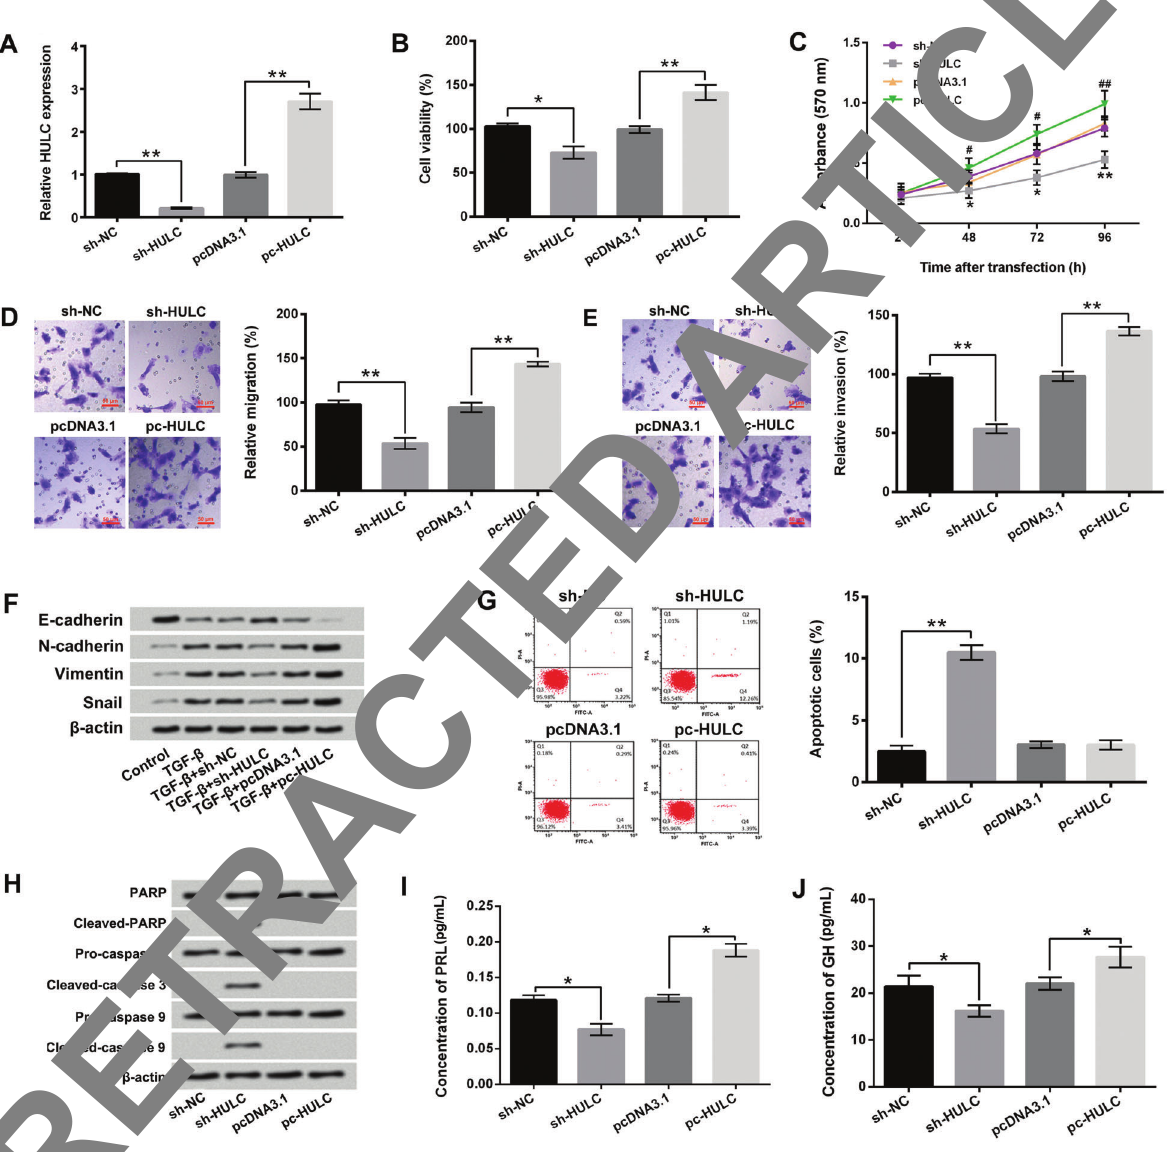
Figure 2. Highly up-regulated in liver cancer (HULC) exerted oncogenic roles in GH3 cells. After sh-HULC or pc-HULC transfection, A , the expression of HULC in GH3 cells, B – E , the viability, migration, and invasion of GH3 cells, F , the expression levels of E-cadherin, N-cadherin, vimentin, and snail in GH3 cells, G , the apoptosis of GH3 cells, H , the expression levels of PARP, cleaved-PARP, pro-caspase 3, cleaved-caspase 3, pro-caspase 9, and cleaved-caspase 9 in GH3 cells, and I and J , the concentration of prolactin (PRL) and growth hormone (GH) in culture supernatant of GH3 cells were assessed using qRT-PCR, trypan blue staining assay, MTTassay, two-chamber transwell assay, Guava Nexin assay, western blotting, and ELISA. NC: negative control; TGF- b : transforming growth factor b ; PARP: poly ADP-ribose polymerase. Data are reported as means ± SD. *P o 0.05, **P o 0.01, # P o 0.05, ## P o 0.01 compared to pcDNA3.1 group